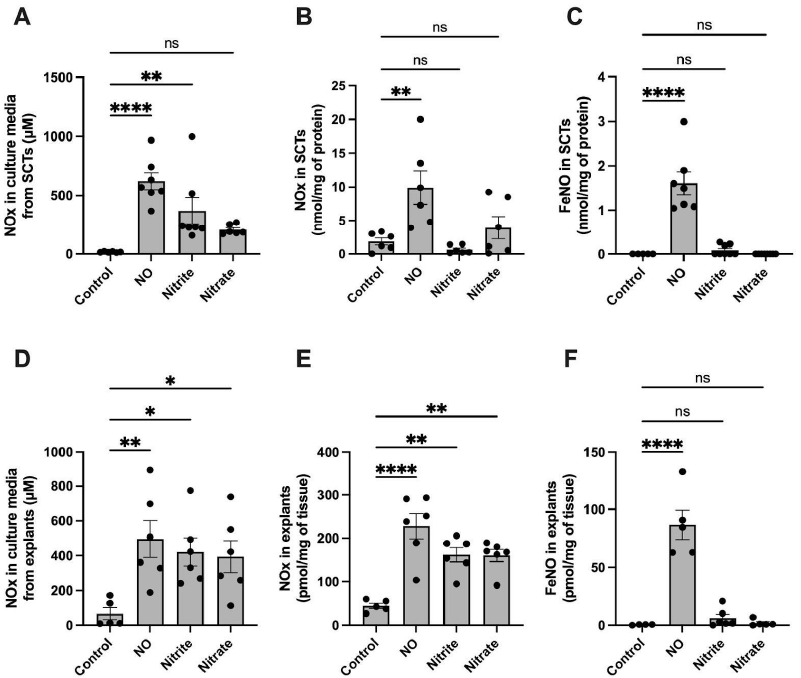
Figure 2. NO metabolites and FeNO formation in cultured BeWo cells and villous explants after 24 h of treatment with NO (as 500 µ M DETA), nitrite (250 µ M), or nitrate (250 µ M). ( A ) Total NOx (NO, nitrite, nitrite, FeNOs, and SNOs) in normoxic cell culture media of syncytialized BeWo cells (SCTs) following 24 h of treatment with NO, nitrite or nitrate. ( B ) NOx (NO, nitrite, FeNOs, and SNOs but not nitrate) found in homogenized syncytialized BeWo cells following 24 h treatment with NO, nitrite, or nitrate. ( C ) FeNO levels found in syncytialized BeWo cells following 24 h treatment with NO, nitrite, or nitrate. ( D ) Total NOx in culture media of human placental explants following 24 h of treatment with NO, nitrite, or nitrate. ( E ) TotalNOx found in human placental explants following 24 h treatment with NO, nitrite, or nitrate. ( F ) FeNO levels found in placental explants following 24 h treatment with NO, nitrite, or nitrate. FeNO formation is significantly increased by the presence of NO but not nitrite or nitrate. Data are reported from at least three independent experiments as mean ± SD, * p < 0.05, ** p < 0.01, **** p < 0.0001, ns = not significant.